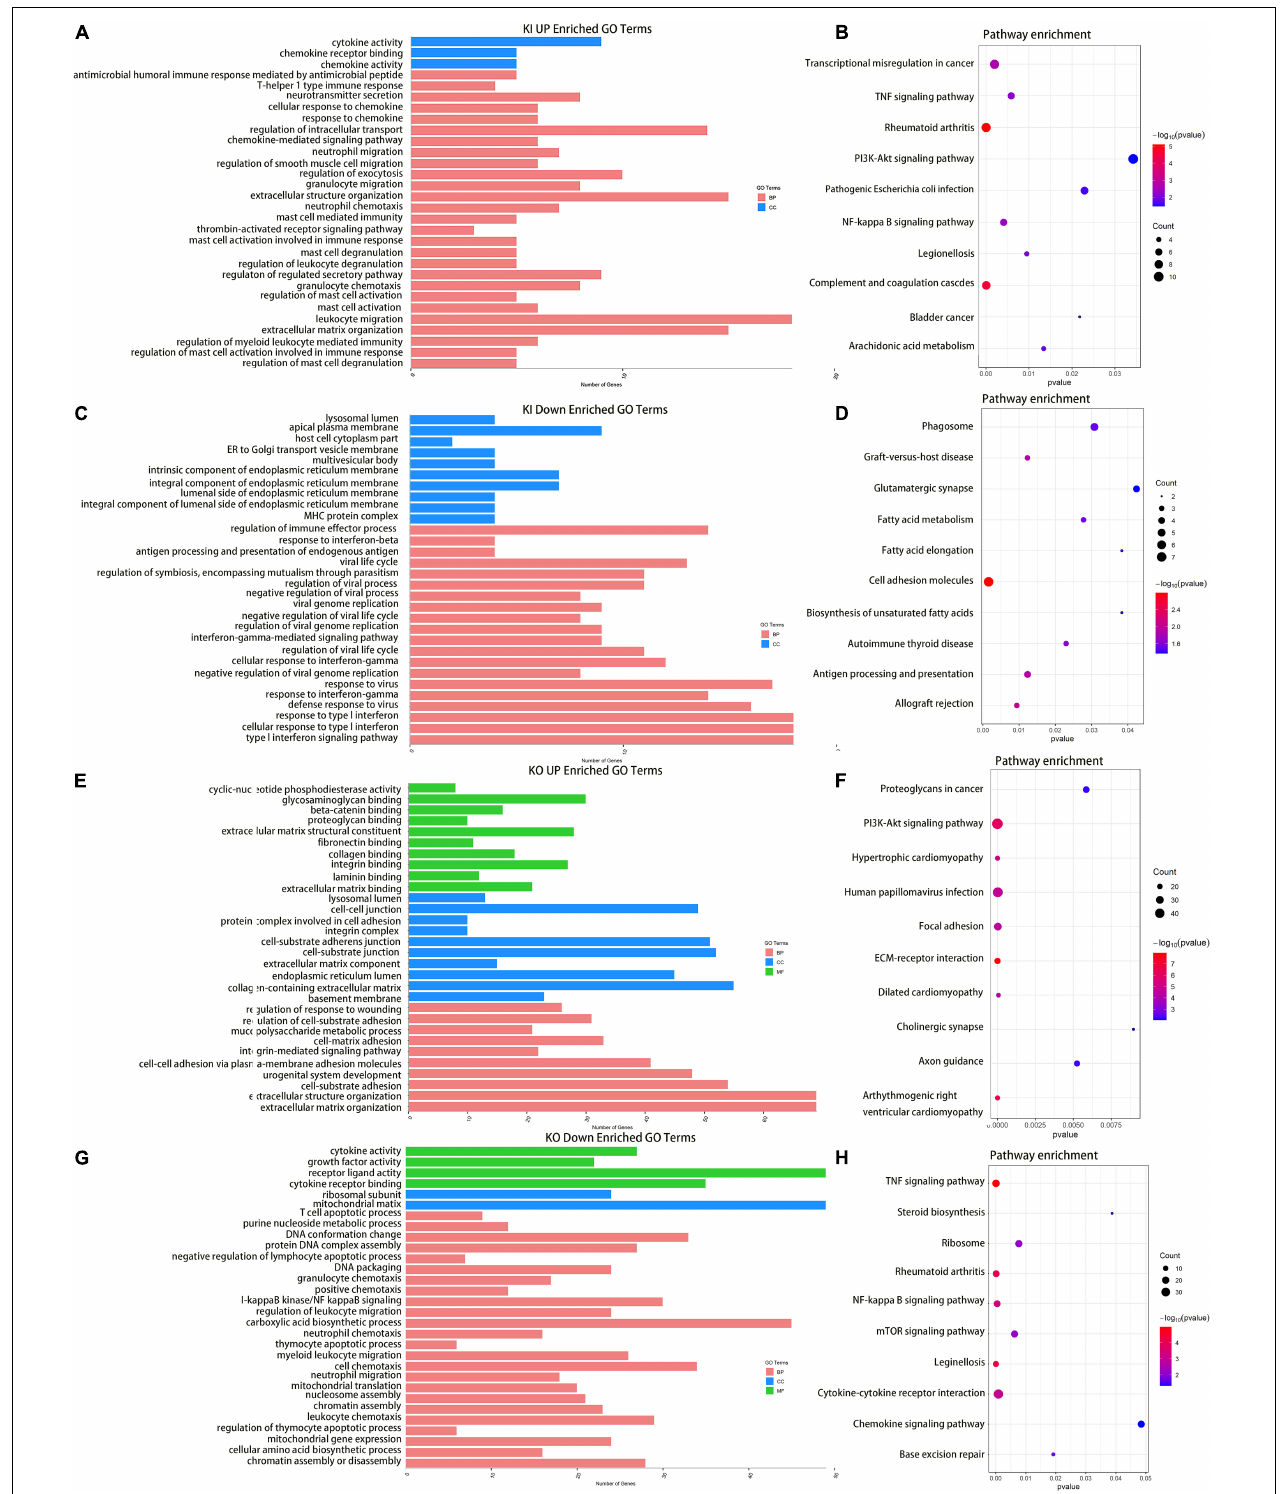
FIGURE 2 | Enrichment Analysis for DEGs upon knocking out and overexpressing U11 in T24 cell lines. (A,C) GO pathways of upregulated and downregulated genes in T24 U11 − KI cell line, respectively. (B,D) KEGG pathways of upregulated and downregulated genes in T24 U11 − KI cell line, respectively. Panels (E,G) are GO pathways of upregulated and downregulated genes in T24 U11 − KO cell line, respectively. Panels (F,H) are KEGG pathways of upregulated and downregulated genes in T24 U11 − KO cell line, respectively. GO: gene ontology; KEGG: Kyoto Encyclopedia of Genes and Genomes.